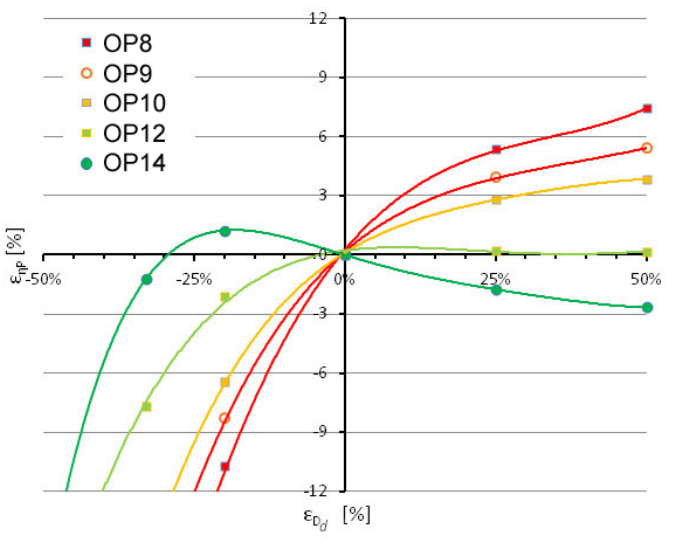
Figure 10. Algorithm sensitivity analysis regarding the determination of the pump efficiency (cid:101) η deviations in the input of the discharge line diameter (cid:101) D OP12 and